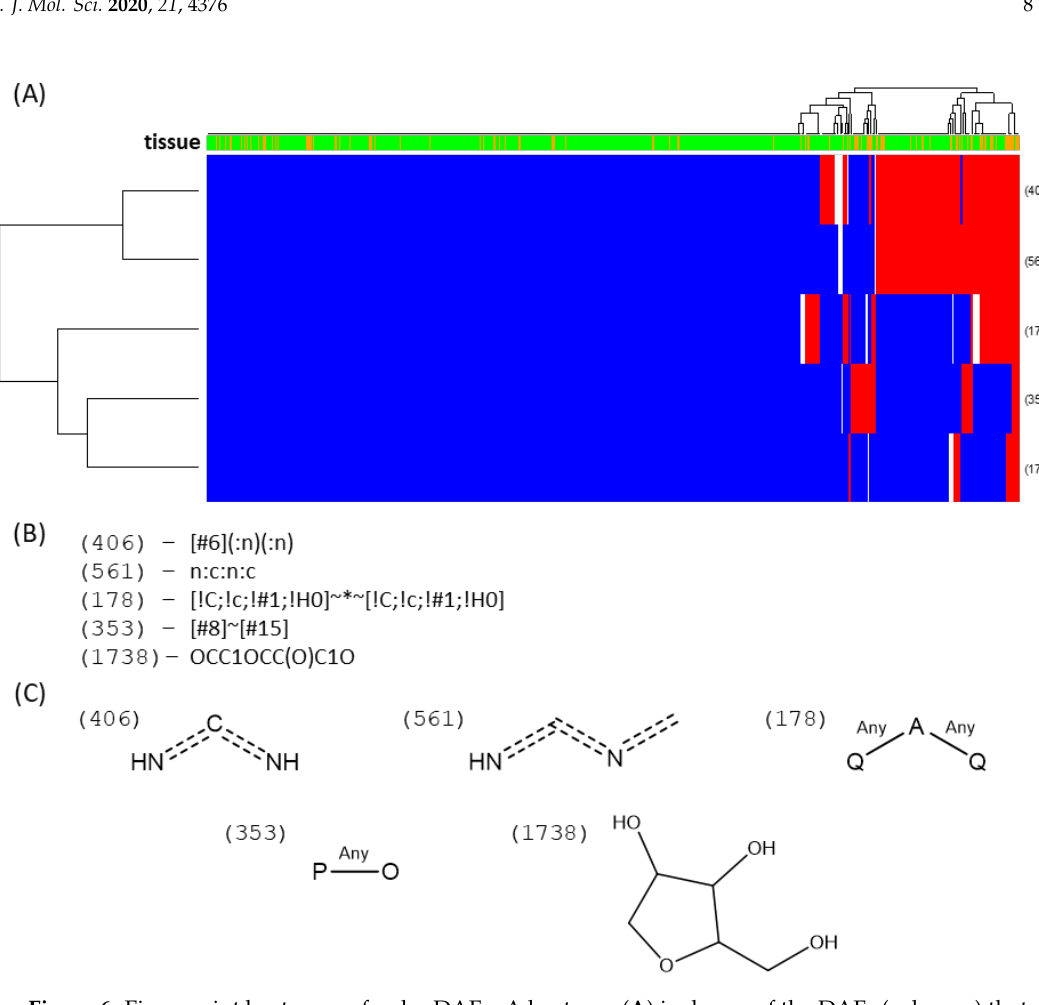
Figure 6. Fingerprint heatmaps of polar DAFs. A heatmap ( A ) is shown of the DAFs (columns) that had a fingerprint vector assigned, with blue cells being present, red being absent, and white being uncertain fingerprints. Given the nature of the sample, being mostly leaf DAFs, only the positive fingerprints enriched in pitcher and absent in leaf are shown. These fingerprints are described in ( B ) and the graphical approximation of their substructure in ( C ). It is important to note that the right-most cluster is unusually enriched in pitcher DAFs, with a high number of positive assignations of most of the selected fingerprints.